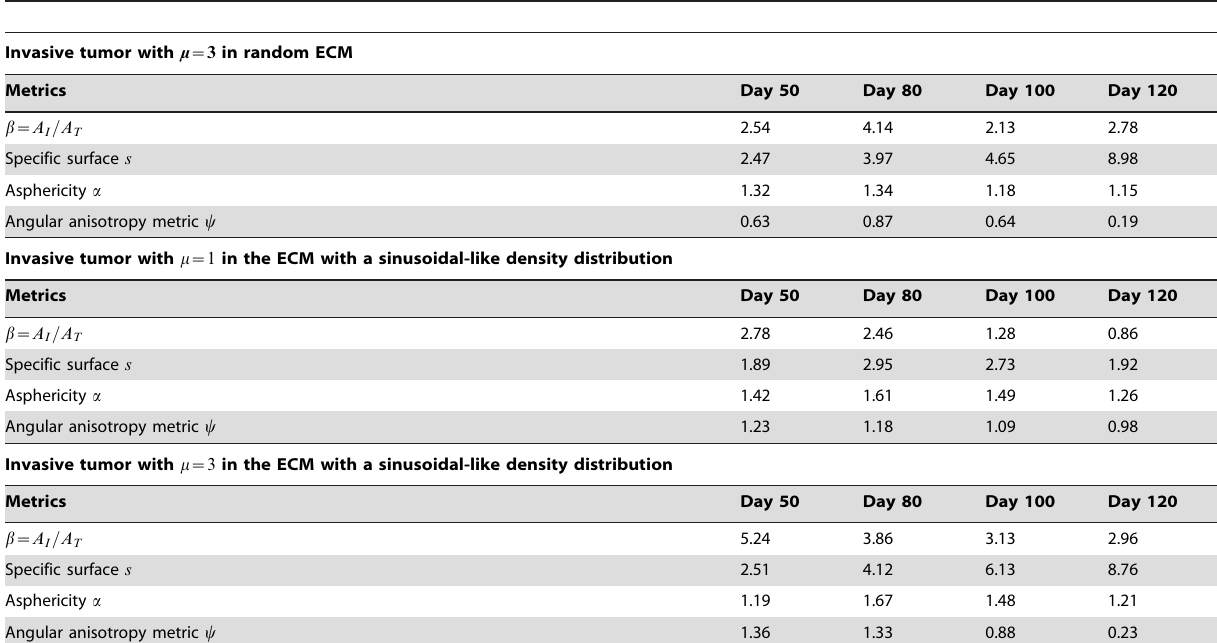
Table 4. Morphology metrics for simulated tumors growing in heterogeneous ECM.